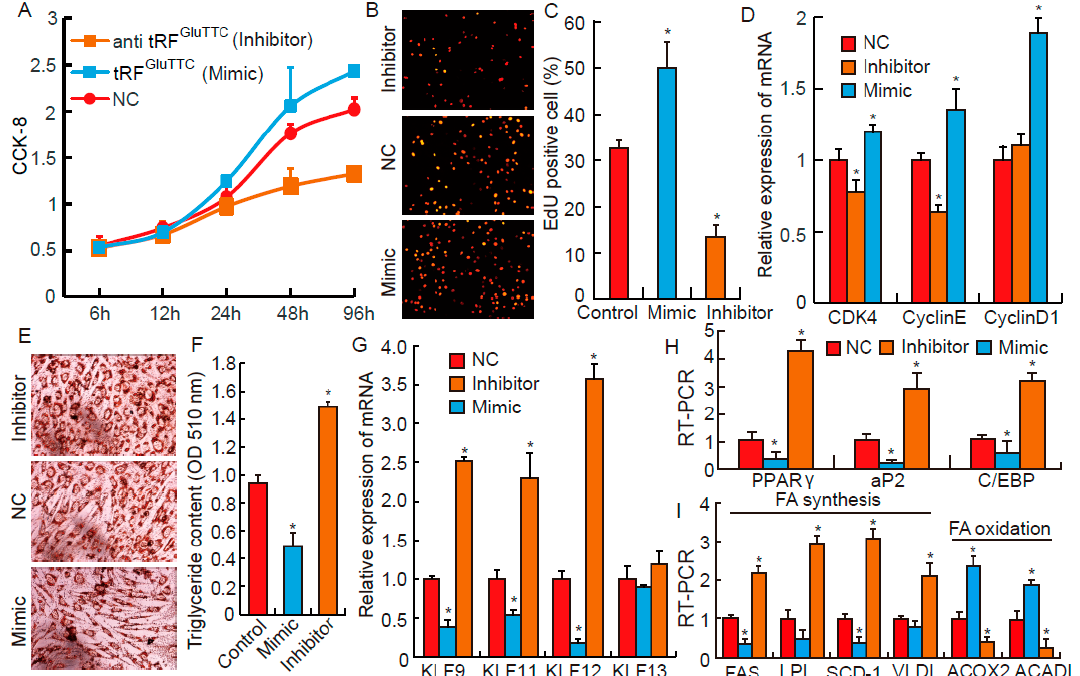
Figure 3. The role of tRF GluTTC in proliferation and differentiation of preadipocytes. ( A ) The proliferation ability of 3T3-L1 preadipocyte was measured by CCK-8. ( B , C ) 3T3-L1 preadipocyte proliferation was measured by EdU staining. ( D ) The relative mRNA expression levels of cell cycle regulatory factors (CDK4, Cyclin E, and Cyclin D1) by RT-PCR. ( E , F ) Oil Red O staining and triglyceride content of terminally differentiated (Day 8) adipocytes that transfected with tRF GluTTC mimics and inhibitors. ( G ) The relative expression of KLF family (KLF9, KLF11, KLF12, and KLF13) by RT-PCR. ( H ) The relative expression of adipogenic transcription factors ( aP2 , peroxisome proliferator-activated receptor gamma ( PPAR γ ), and CCAAT enhancer binding protein alpha ( C/EBP α )) by RT-PCR. ( I ) The relative expression of genes related to fatty acid synthesis and oxidation by RT-PCR. All data were presented as means ± standard deviation. * p < 0.05.